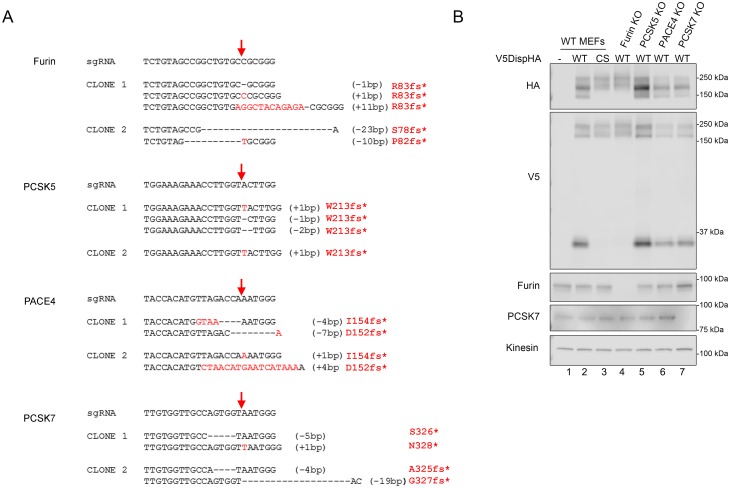
(A) Genotype of PC family knockout clones. Red arrows indicate the Cas9 cleavage site. sgRNA sequence (5’ to 3’) is shown for each targeted gene along with corresponding deletions (black dashes) and insertions (red letters) identified by deep sequencing of knockout clonal lines. Insertion/deletion sizes are indicated in parenthesis and resulting premature truncation amino acid is shown in red. (B) CRISPR/Cas9 generated knockout lines for Furin, PACE4, PCSK5 and PCSK7 were transfected with V5DispHA-expression vector, and formation of the ~30 kDa V5 cleavage fragment was monitored by western blot of cell lysates from Clonal line 2. Furin and PCSK7 protein levels were examined by western blot. Kinesin is loading control. PACE4 and PCSK5 were assessed by deep sequencing as in A.